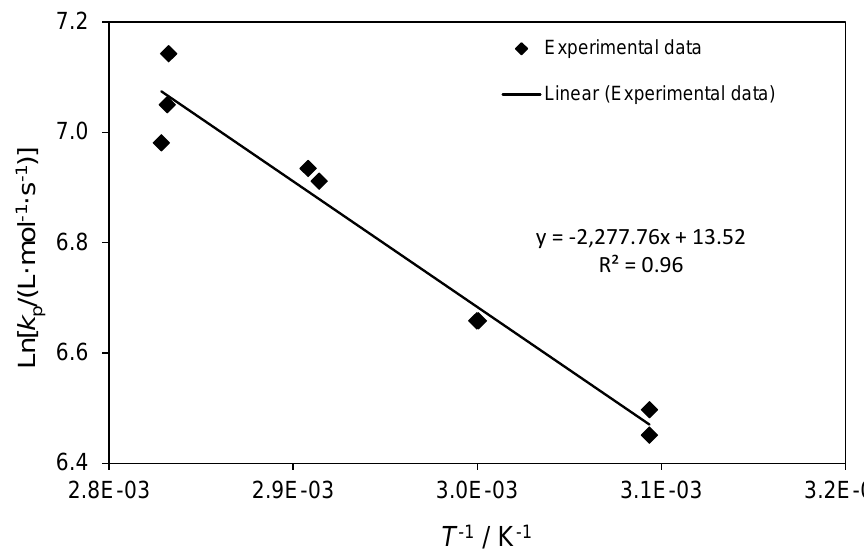
Figure 1. Arrhenius plot of the propagation rate coefficient k p for tert -butyldimethylsilyl methacrylate polymerization. Points: experimental data; line: best fit of linearized Arrhenius equation to points.